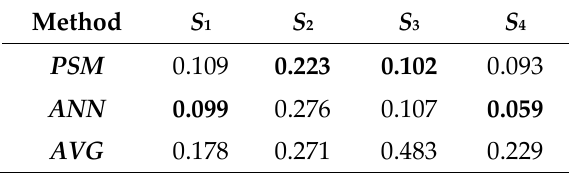
Table 5. MAPE values obtained in each segment of the route of line L 303